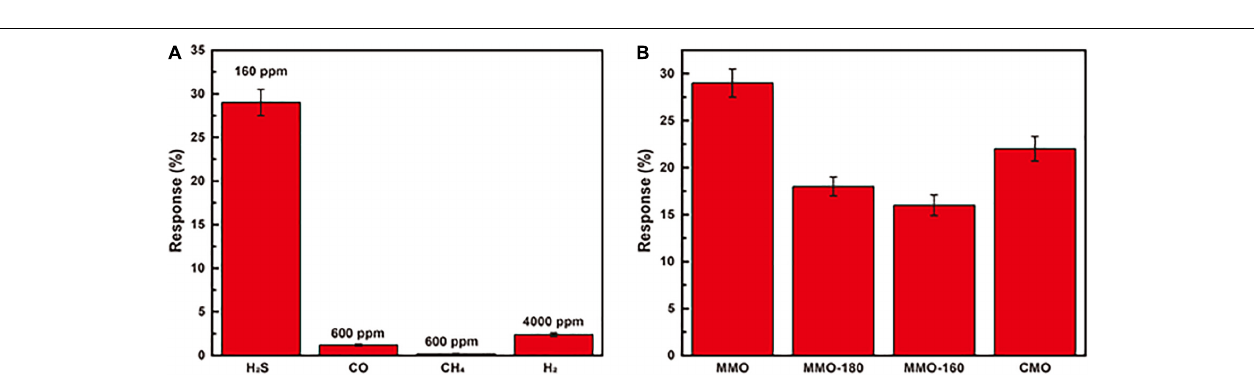
FIGURE 3 | (A) The response of MMOs to 10 ppm H 2 S at different working temperature; (B) the response of MMOs to different H 2 S concentration at 100 ◦ C; (C) the real-time response of MMOs to 40 ppm H 2 S at 100 ◦ C; (D) five response cycles of MMOs to 40 ppm H 2 S at 100 ◦ C.